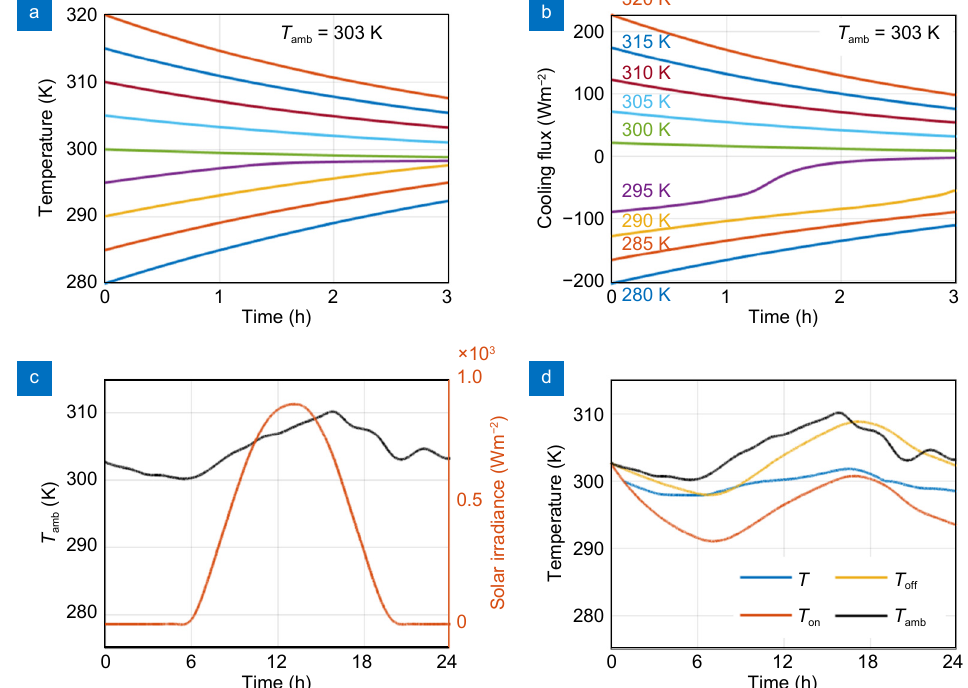
Fig. 5 | Temperature variation in time. ( a ) Temperature and ( b ) cooling flux in time for initial temperature of 280 K to 320 K with 5 K step. Tem- perature indicate the initial temperature of the cooler. T amb = 303 K. ( c , d ) A cycle of temperature of a day. (c) T amb and solar irradiance of July 15, 2018 in Pohang, Korea. (d) Temperature of switchable radiative cooler (blue) and the static radiative cooler when radiative cooling is as- sumed to be turned on (orange) and off (yellow). T amb is shown as a reference (black). Initial temperature of the cooler is set equal to the initial T amb